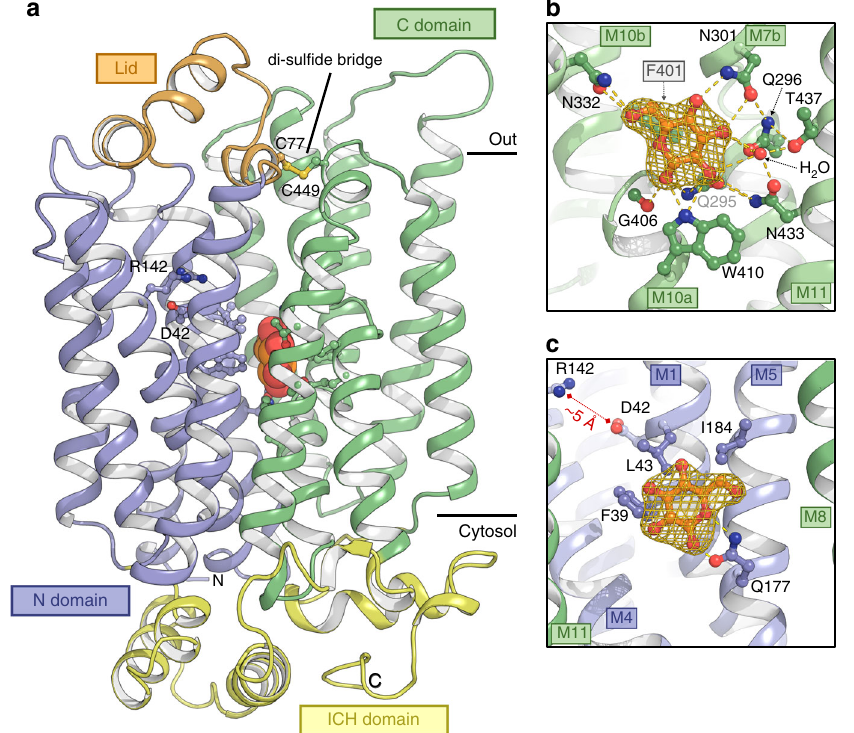
Fig. 1 Structure of the high af fi nity Sugar Transport Protein STP10. a The structure represents an outward facing occluded state of the sugar transporter in complex with glucose. Glucose (shown as spheres) is buried in the membrane at the interface between the N domain (blue) and C domain (green). Selected residues are shown as sticks. Black bars depict the approximate location of the membrane. b The glucose binding site towards the C domain. Yellow dashes indicate hydrogen bonds (2.6 – 3.6 Å distances) to glucose. The omit mFobs-DFcalc density for glucose is contoured in gold (5 σ ). c Same as panel b for the glucose binding site towards the N